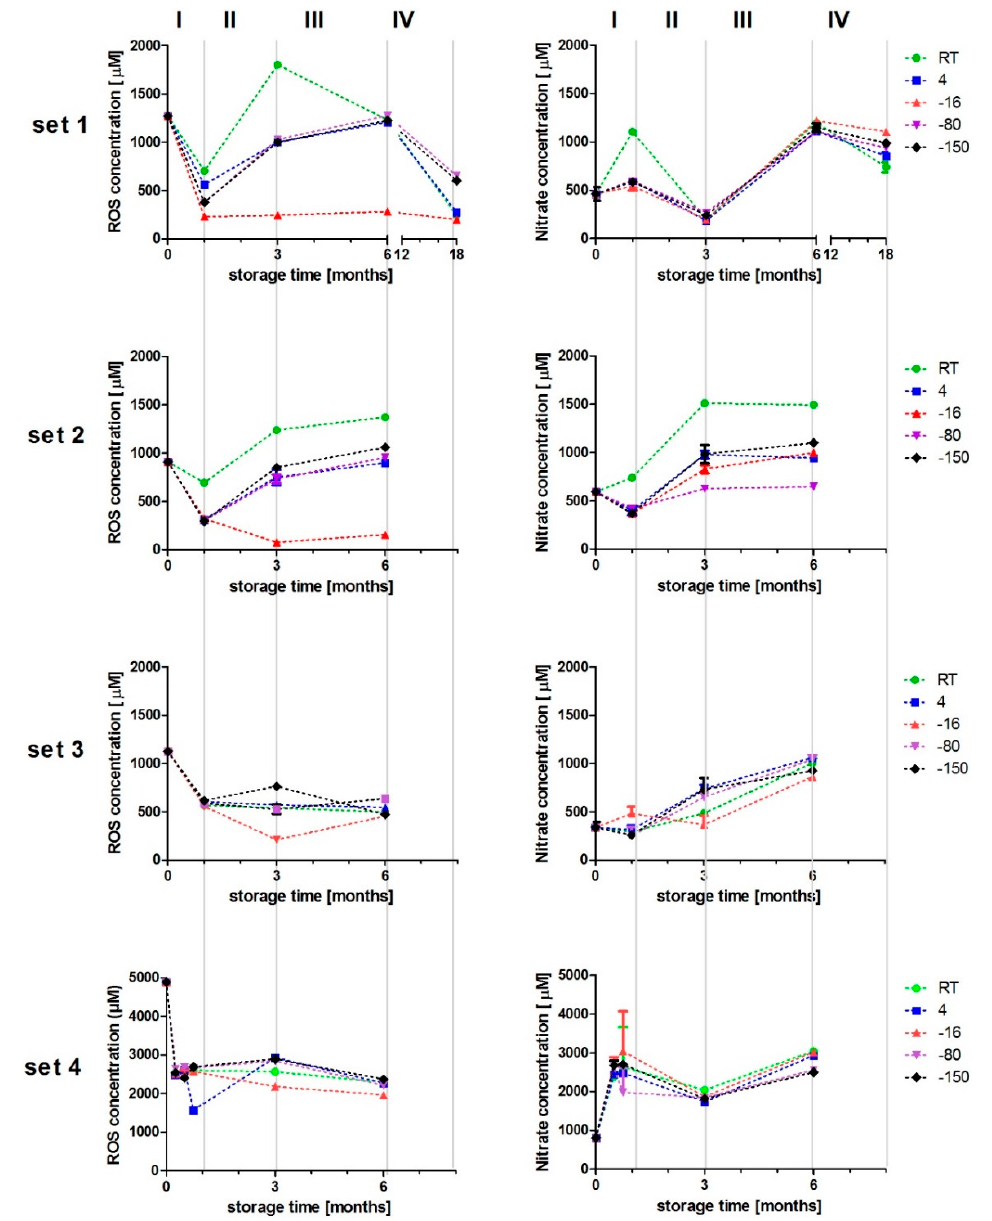
Figure 8. Chemical properties of four different sets of PAS stored at different temperatures for 6–18 months showing ROS concentrations in the column on the left and nitrate concentrations in the column on the right. Samples were analysed after 1, 3 and 6 months and 18 months (sets 1 and 2). Set 4 was also analysed after 1, 2 and 3 weeks of storage.